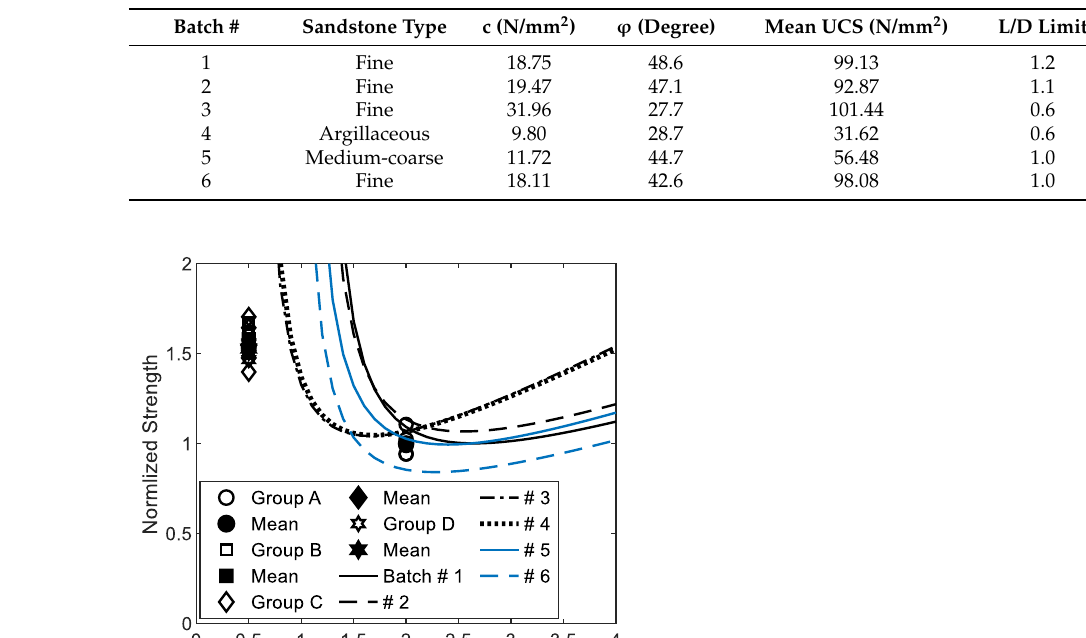
Table 10. Mechanical properties of sandstone (after [116]).